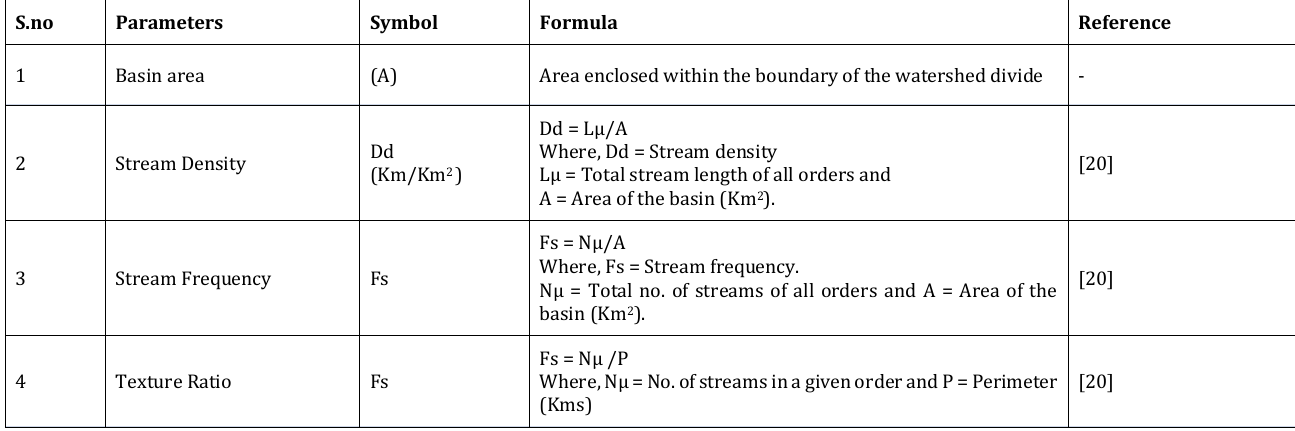
Table 3: Method of calculating aerial aspects of drainage